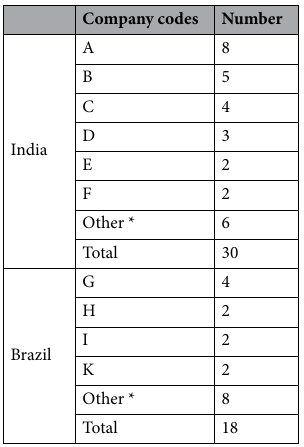
Table 2. Sources of contaminated samples classified by countries and companies. *Less than two contaminated samples by company.